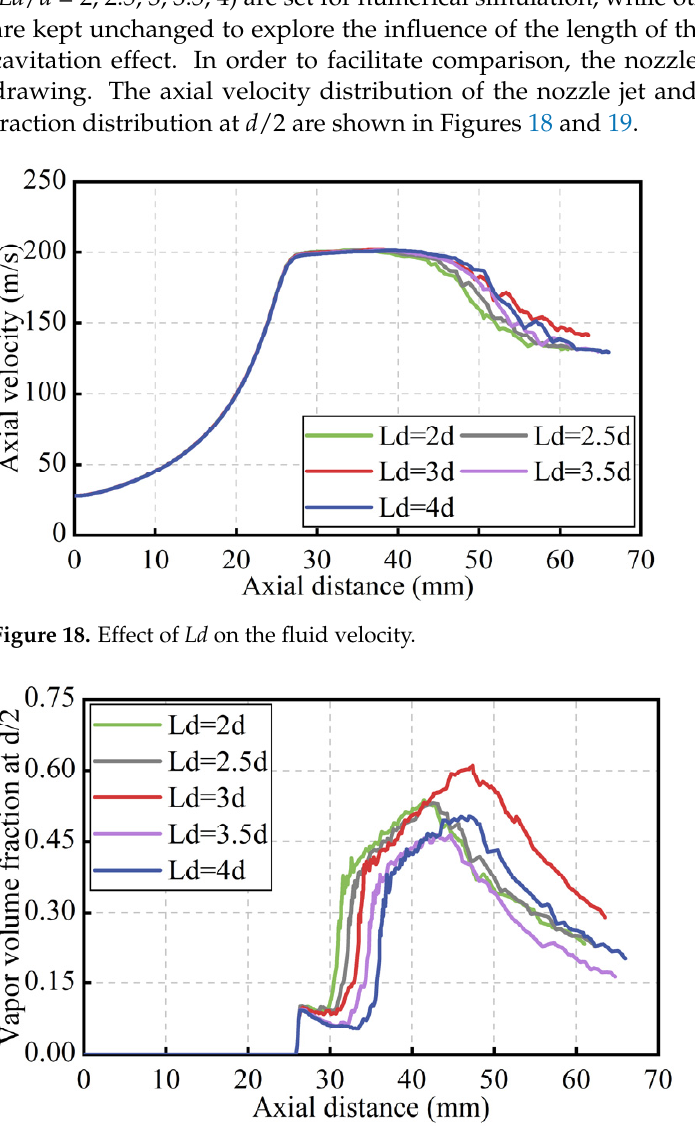
fluctuates up and down. The length of the dimensionless cylindrical section with a value of 3 has the largest axial velocity of the